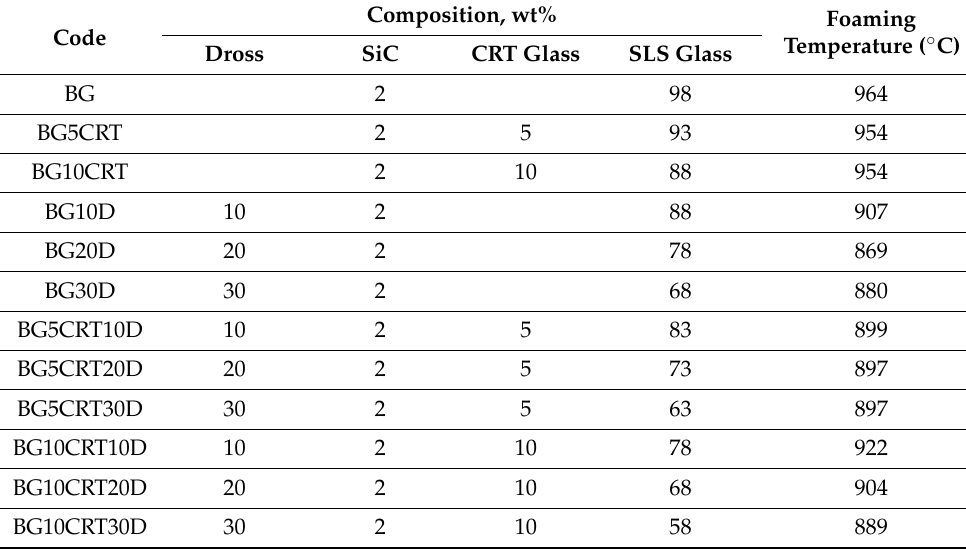
Table 1. Composition and foaming characteristics of the